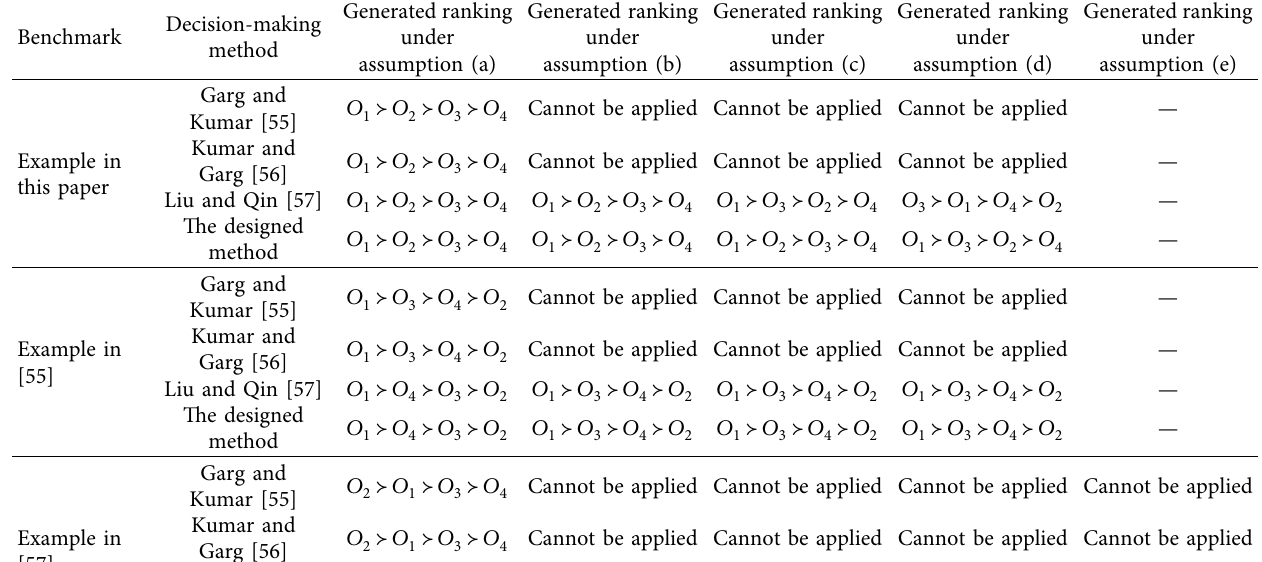
Table 6: The details and results of the first additional quantitative comparison experiment.